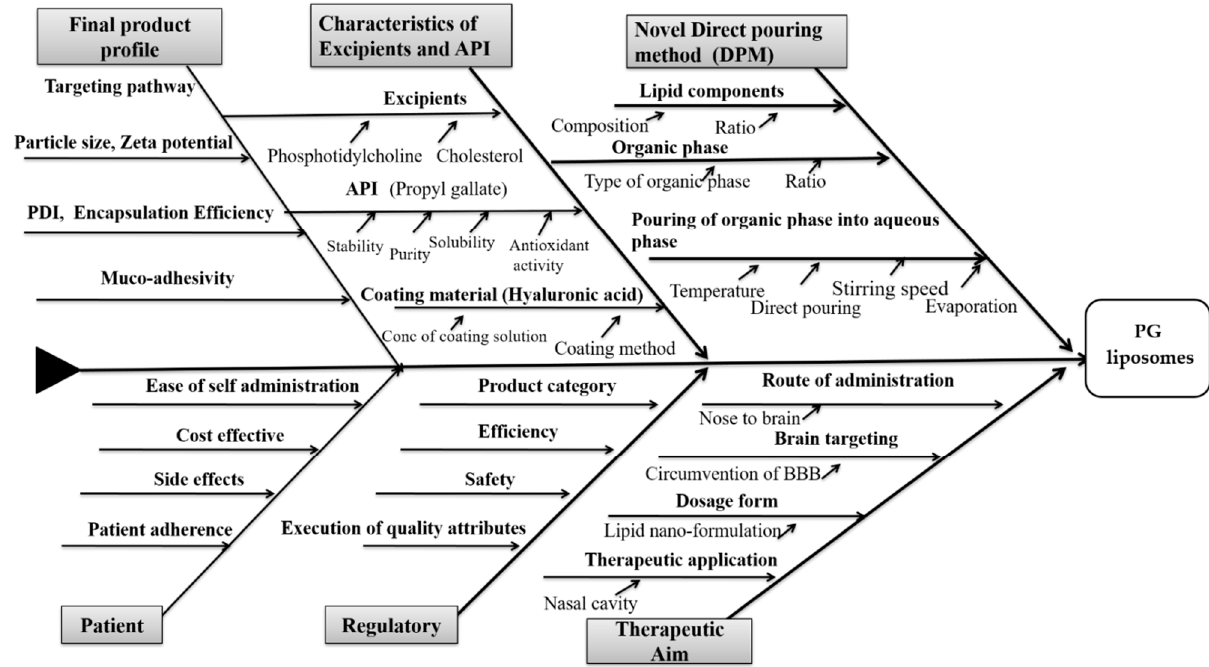
Figure 2. Ishikawa diagram showing the cause-and-effect relationships between influencing factors of hyaluronic acid (HA)-coated, n-propyl gallate (PG)-loaded liposomes for nose-to-brain drug delivery. Table 1. Selection of quality target product profiles (QTPPs) of PG-loaded liposomes for nose-to-brain delivery, along with respective target and